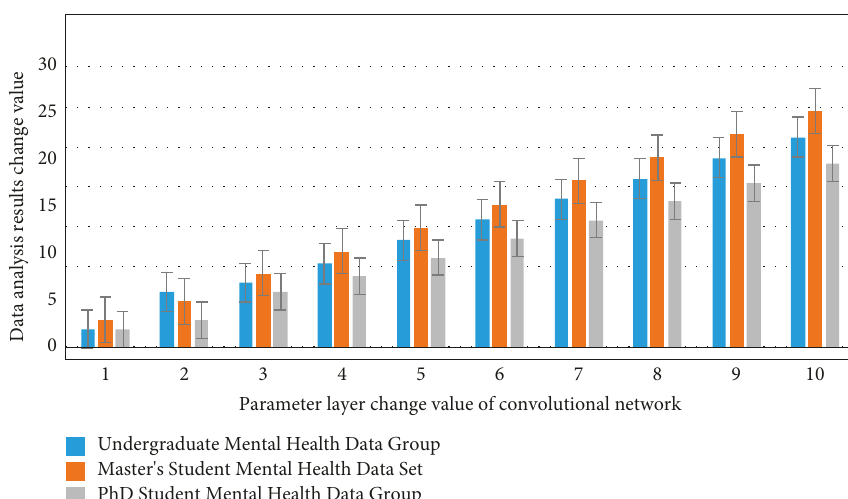
Figure 4: Variation trend of data redundancy of different students (4 data balance factors).